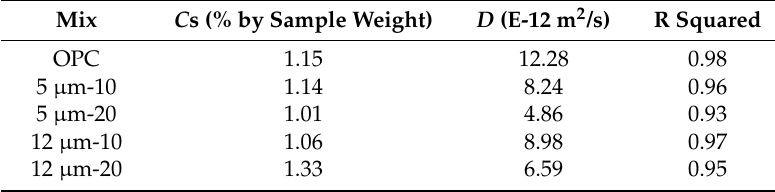
Figure 8. Concentration profiles for ( a ) free chloride, and ( b ) total chloride. Table 4. Diffusion parameters obtained from the total chloride concentration profile.